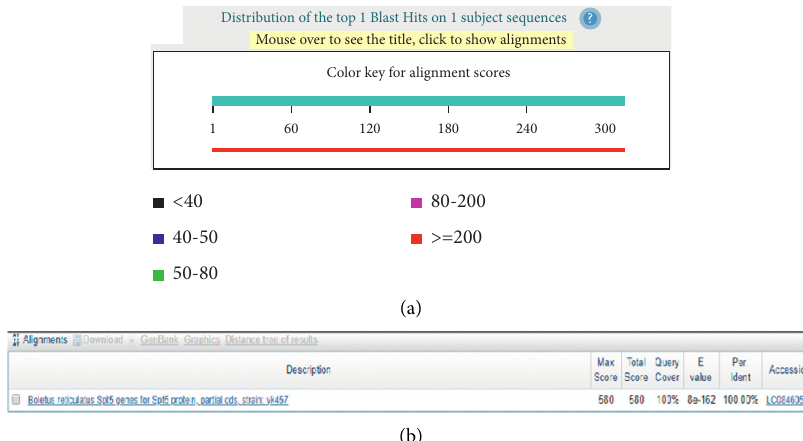
Figure 2: The homology analysis of spt5 gene. (a) The BLAST analysis of spt5 in the nucleotide collection database. (b) The detail in- formation about the BLAST